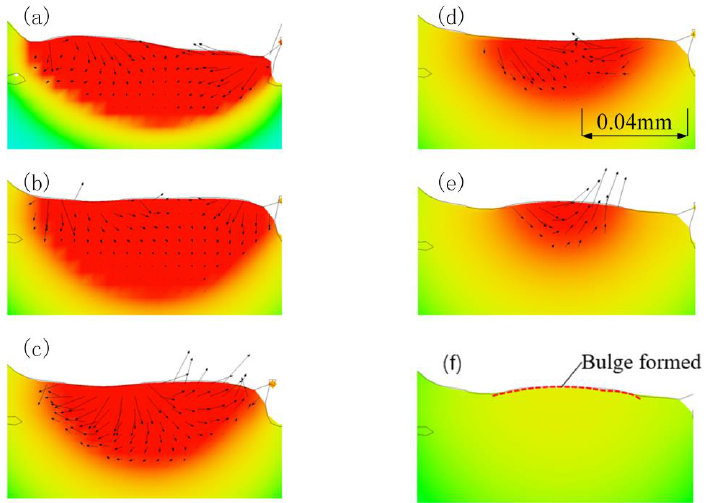
Figure 15. The formation of bulge in LP process. ( a ) t = 1.70 ms; ( b ) t = 1.85 ms; ( c ) t = 1.90 ms; ( d ) t = 1.95 ms; ( e ) t = 2.00 ms; ( f ) 2.15 ms. The parameters of SLM were 150 W, 0.8 m/s and 0.05 mm. The parameters of ILP were 130 W, 0.8 m/s and 0.05 mm. The entire domain is 0.11 mm long and 0.06 mm high.